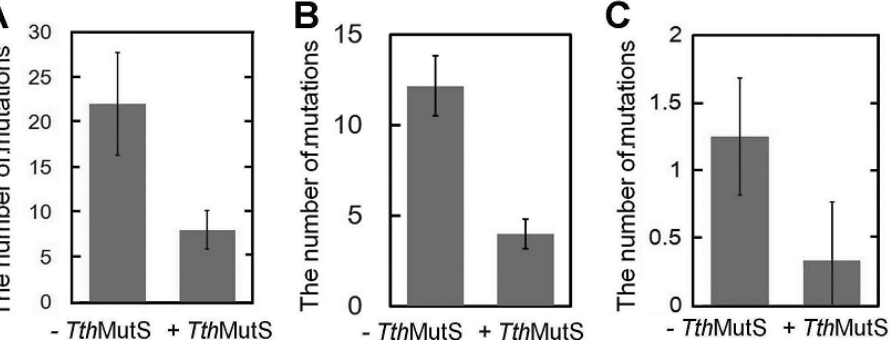
Figure 8. Tth MutS suppressed DNA polymerase-generated mutations during PCR. ( A ) A 423-bp fragment of ttha1806 was amplified in the presence of 200 μ M MnCl with or 2 without 1.1 μ M Tth MutS, cloned into the pT7Blue vector and sequenced using the T7 promoter primer. The numbers of mutations in the fragment are shown; the values represent the mean ± standard deviation for five independent experiments; ( B ) A 423-bp and 400 μ M fragment of ttha1806 was amplified in the presence of 200 μ M MnCl 2 adenylyl imidodiphosphate (AMPPNP) with or without 1.1 μ M Tth MutS, cloned into the pT7Blue vector and sequenced using the T7 promoter primer; ( C ) ttha1548 was amplified in the absence of MnCl , cloned into the pT7Blue vector and sequenced using the T7 2 promoter and U-19-mer primers. Mutations in the 5'- and 3'-terminal 500 bp-regions of ttha1548 were